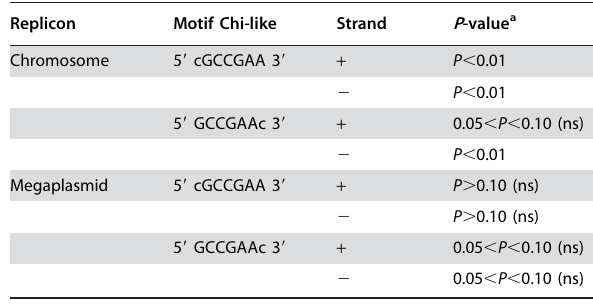
Table 3. Results of the Watson uniformity test for the two Chi motifs on the R. solanacearum chromosome and